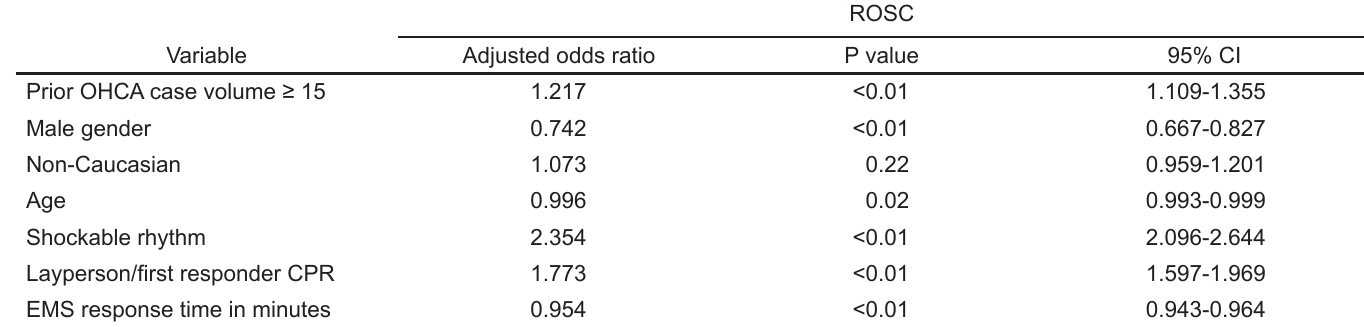
Table 3. Adjusted odds ratios for selected predictors of return of spontaneous circulation (ROSC) among patients enrolled in a study of